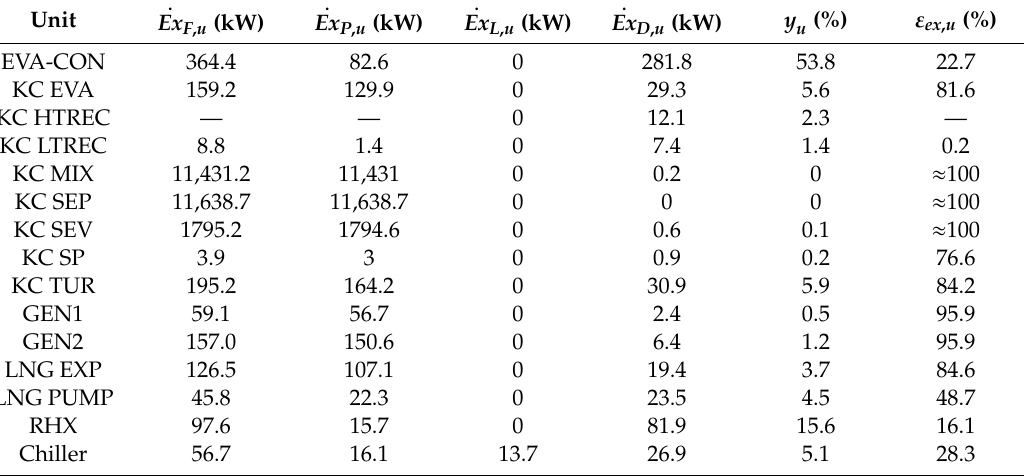
Table 6. Exergy rates of the fuel, product, destroyed exergy, exergy loss, and exergy e ffi ciency for the poly-generation units at nominal